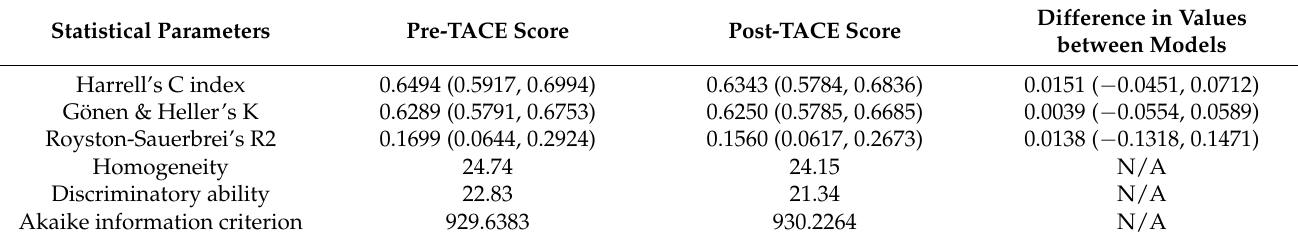
Table 4. Performance of Pre- and Post-TACE score. Statistical Parameters Pre-TACE Score Post-TACE Score